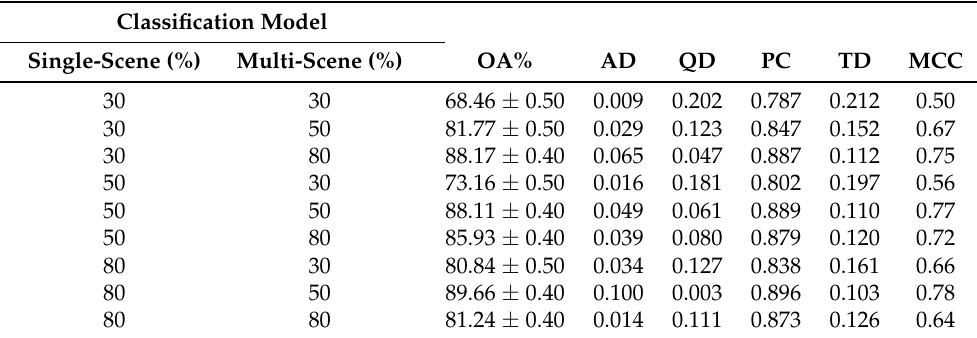
Table 3. Evaluating classification models performance using accuracy assessment metrics for binary classification (forest/non-forest).